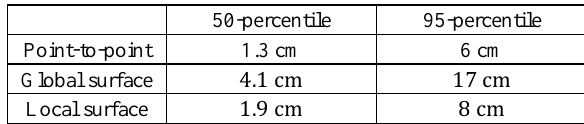
Table 3. The 50- and 95- percentile for the three considered